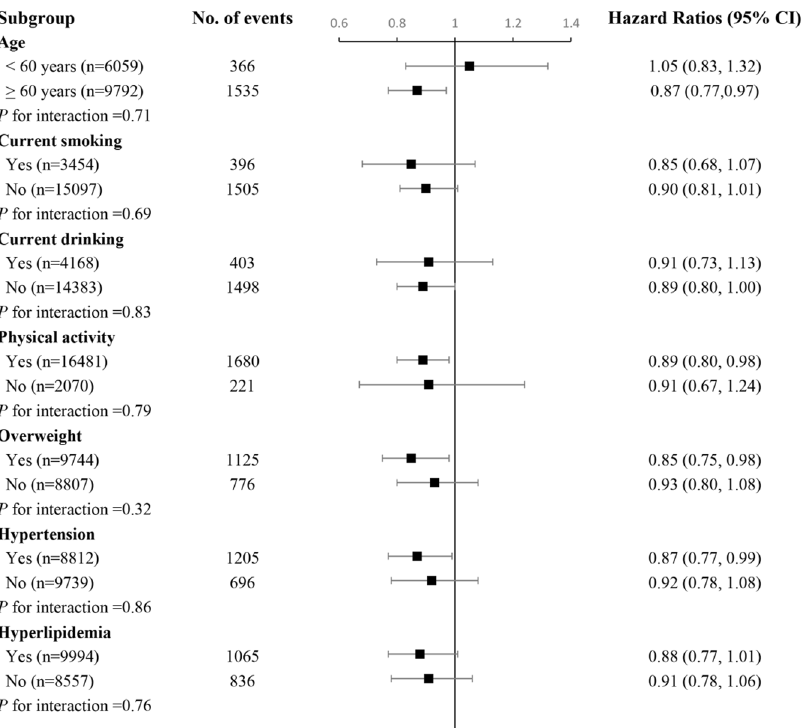
Figure 1. Subgroup analysis of association between education and the risk of incident CHD according to potential risk factors. All covariates were age, smoking, drinking, physical activity, marital status, stress, fruit intake, vegetable intake, BMI, waist circumference, hypertension, hyperlipidemia, diabetes, and family history of CHD. Each group adjusted for the other covariates except itself. The reference group was low education. Horizontal lines represent 95% confidence